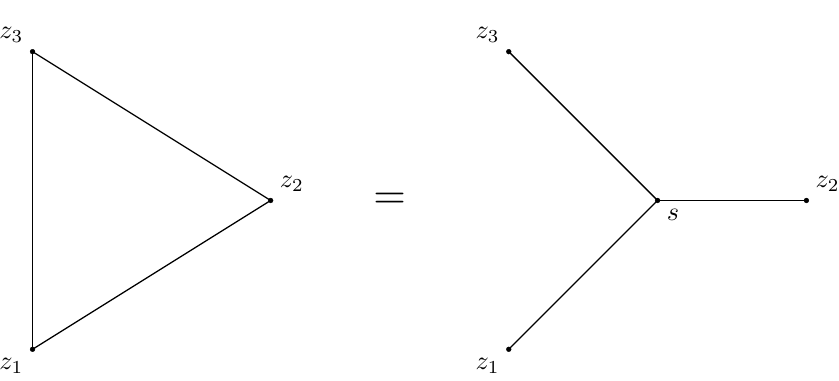
Figure 15 . Diagrammatic representation of the ultimate penthagon identity. Internal points are the Coulomb branch coordinates over which we integrate in the partition function, while external points correspond to fugacities for the (cid:13)avor symmetries. Each line represent a pair of a chiral and an anti-chiral charged under the symmetries corresponding to the points they